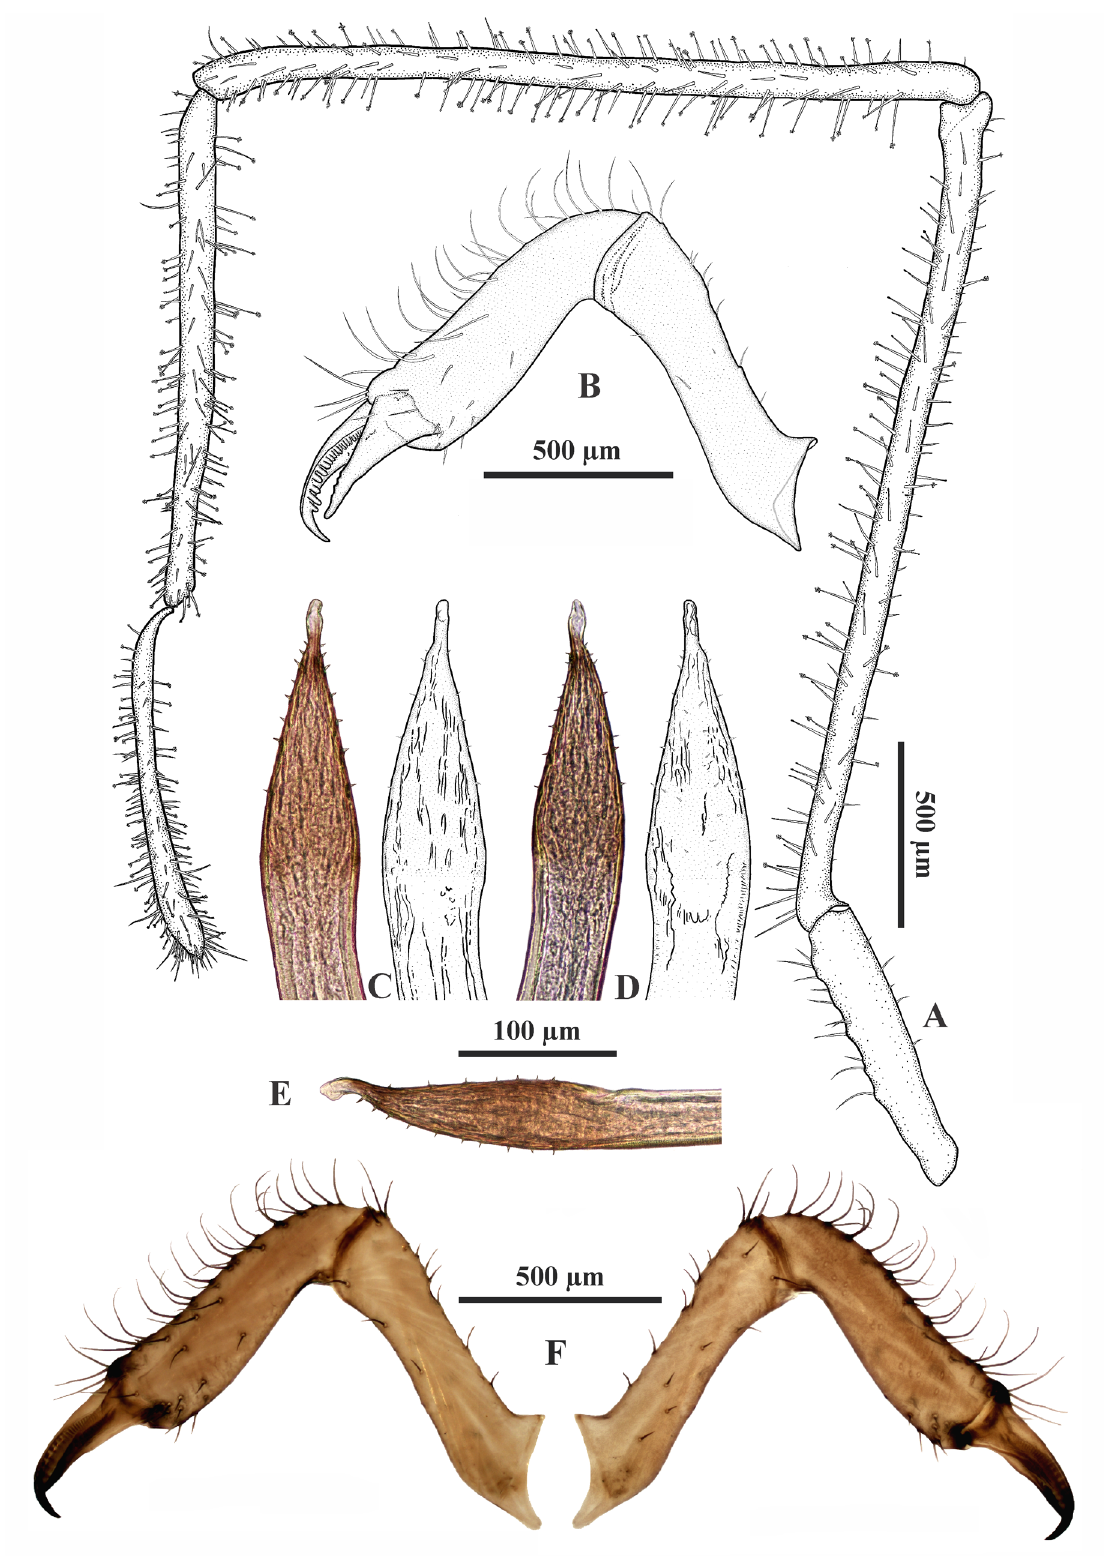
Fig. 2. Nemaspela borkoae sp. nov., ♂, holotype (PMSL-Opiliones-PK&TN 4/2019). A . Right pedipalp, medial view. B . Right chelicera, medial view. C . Penis, ventral view. D . Penis, dorsal view. E . Penis, lateral view. F . Right chelicera, medial (left) and lateral (right)